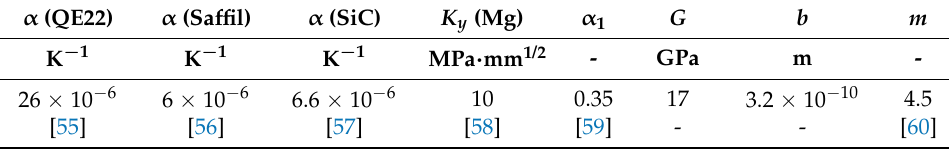
Table 4. Constants used for calculations of the strengthening terms, data from